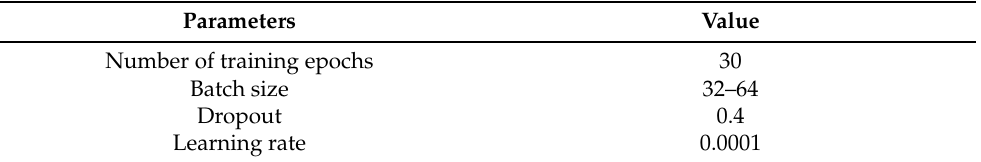
Table 1. Training parameters used in transfer-learning models in this study. Parameters